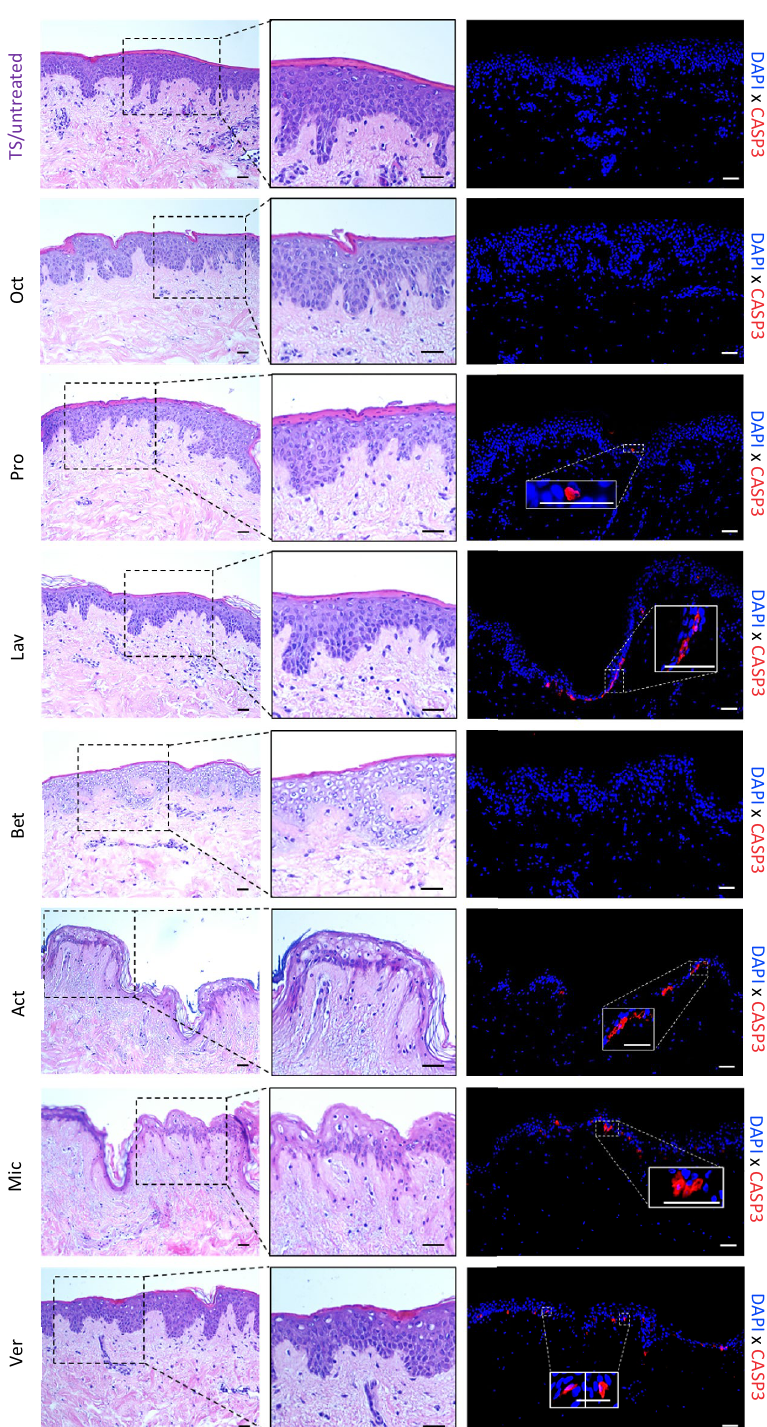
Figure 3. Assessment of the skin structure and apoptosis upon treatment with wound gels. Representative images and zoom-ins of the boxed areas of haematoxylin and eosin (H&E)-stained tape-stripped (TS) sections from biopsies (age 38 years) either left untreated or treated with indicated wound gels using a light microscope. The presence of caspase-3 expressing cells was evaluated using a caspase-3 (CASP3) antibody and visualisation with a secondary Alexa Fluor™ 546 AB (red). Nuclei were counterstained with DAPI (blue). Scale bar = 50